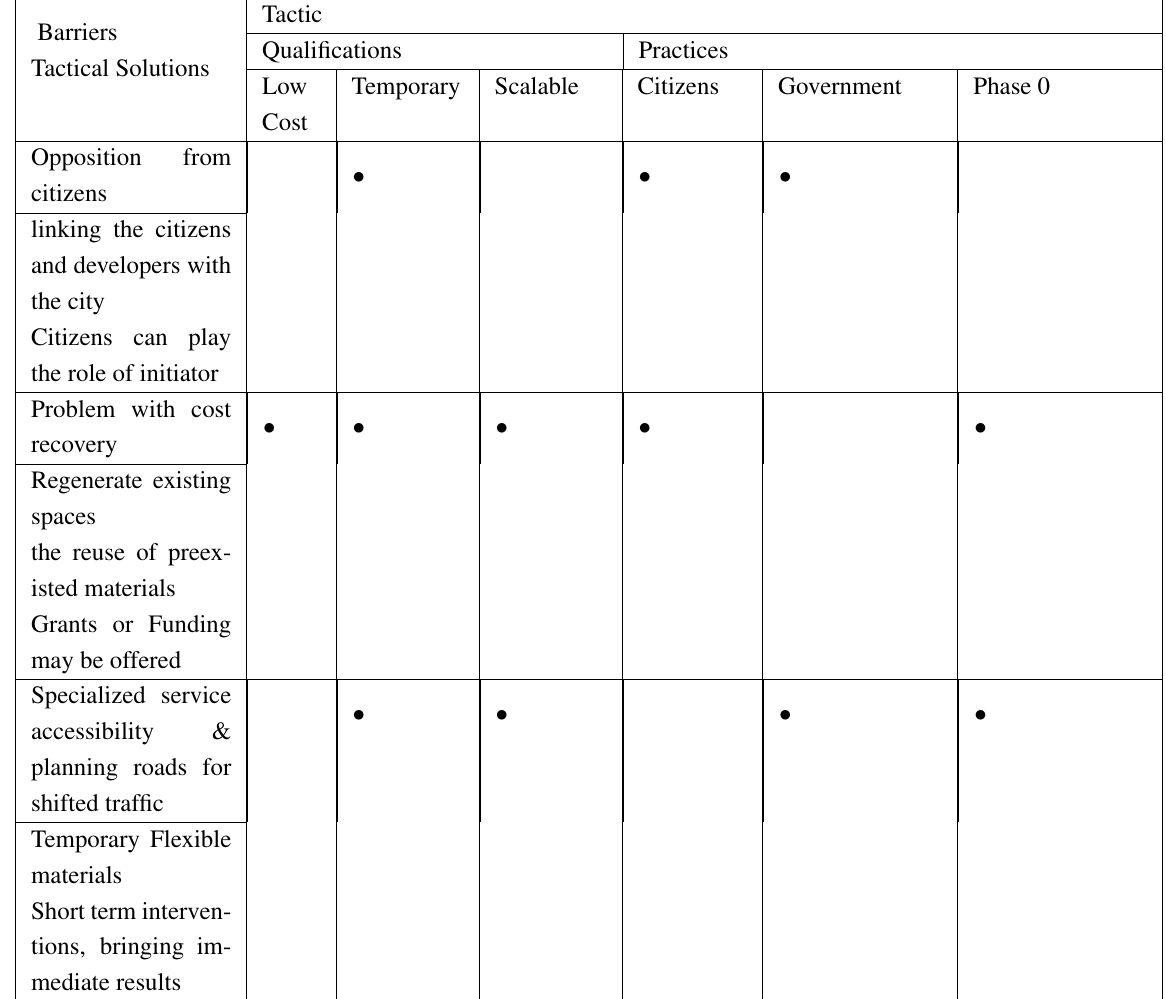
Table 1. Shows the tactical qualifications and practices potentials in breaking barriers of pedestrianization (Researcher,